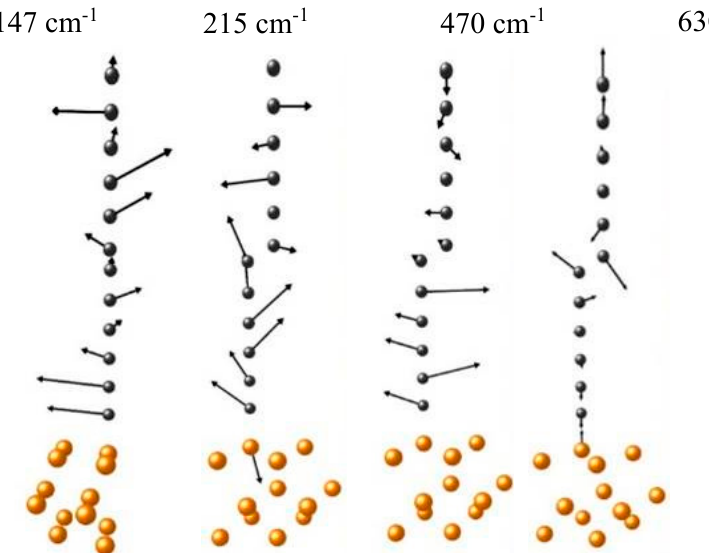
Figure 8. Eigenvectors for the low-frequency Raman modes for a carbyne (black) on the copper surface. Reproduced with permission from [33].